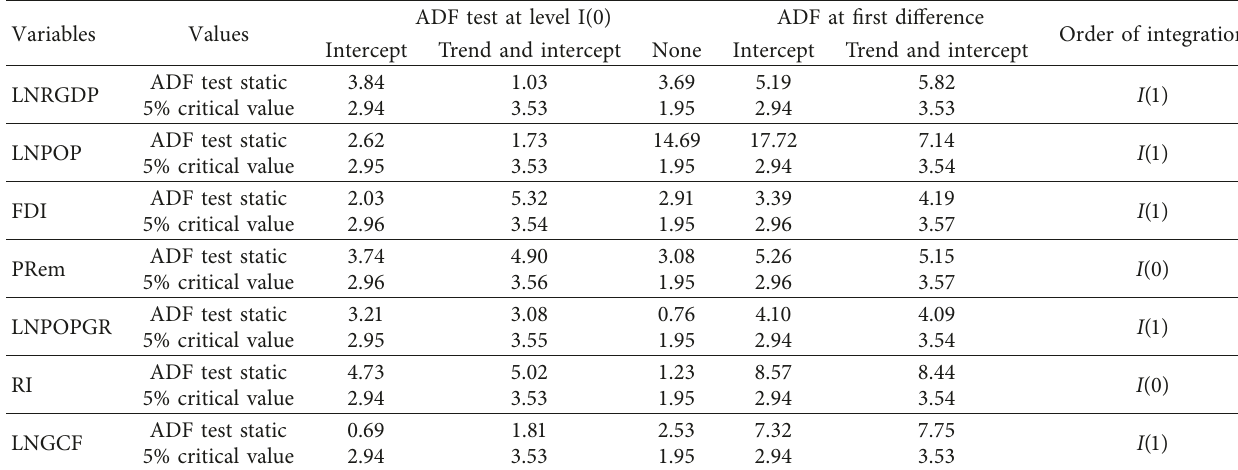
Figure 2: Graph of population growth rate (POPGR) of Ethiopia 1980 up to 2020. Source: authors’ own computation based on World Bank data. Table 1: ADF test for the unit root